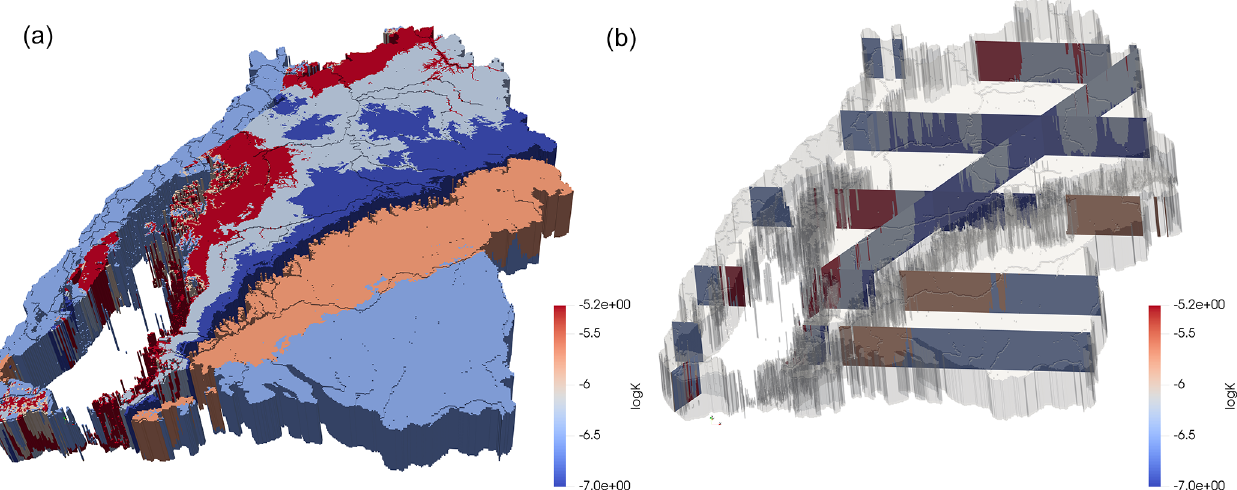
Figure A1. Stratigraphy in the state of Baden-Württemberg represented by its logarithmic conductivity. The left figure shows a 3-D view of the 100m deep geological model used in this work, where the elevation has been neglected for readability and the transparent region corresponds to low-permeable material. The right figure shows the same using cross-sections to better visualize the vertical heterogeneity.